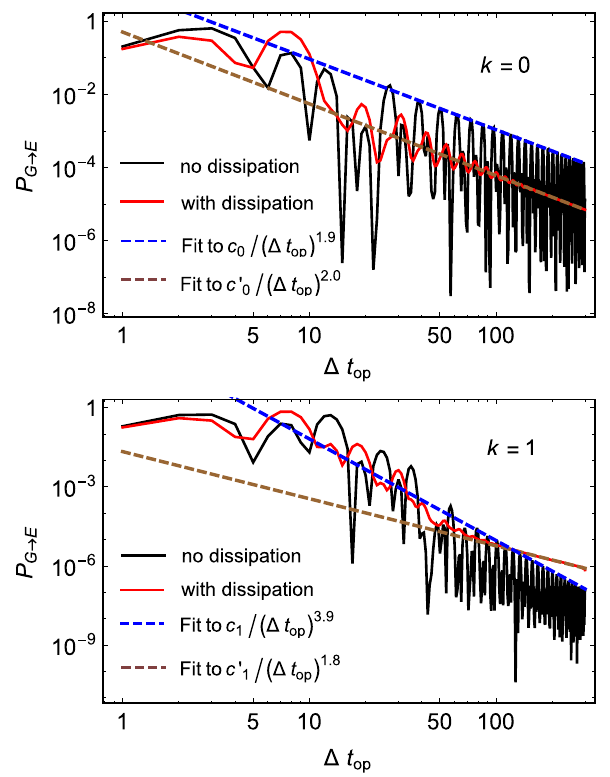
FIG. 2. With dissipation (red solid line), transition probability P vs the gap multiplied by the total evolution time Δ t , due G → E op to diabatic effects for k ¼ 0 (top panel) and k ¼ 1 (bottom panel). x with x ≈ 2 (brown The long time tail is fitted to c 0 = ð Δ t op Þ 10 Δ , Ohmic bath at dashed line). We choose the cutoff ω c ¼ low temperature T ¼ 1 = β ¼ 0 . 001 Δ , and system-bath coupling λ λ λ 0 . 01 Δ . The black solid line shows the results 1 ¼ 2 ¼ 3 ¼ without dissipation, and the envelope function for long times is x with x ≈ 2 k þ 2 (blue dashed fitted to c 0 0 = ð Δ t op Þ